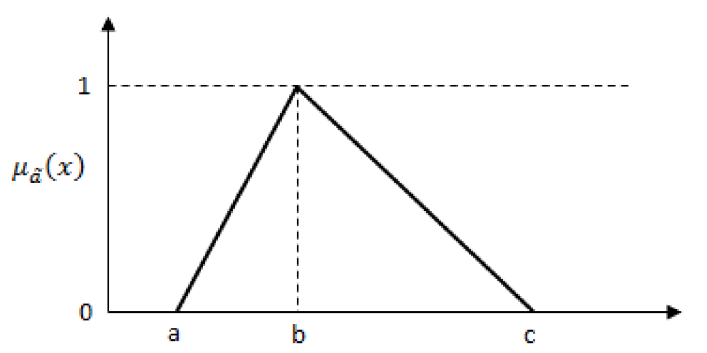
Figure 1. Triangular fuzzy number